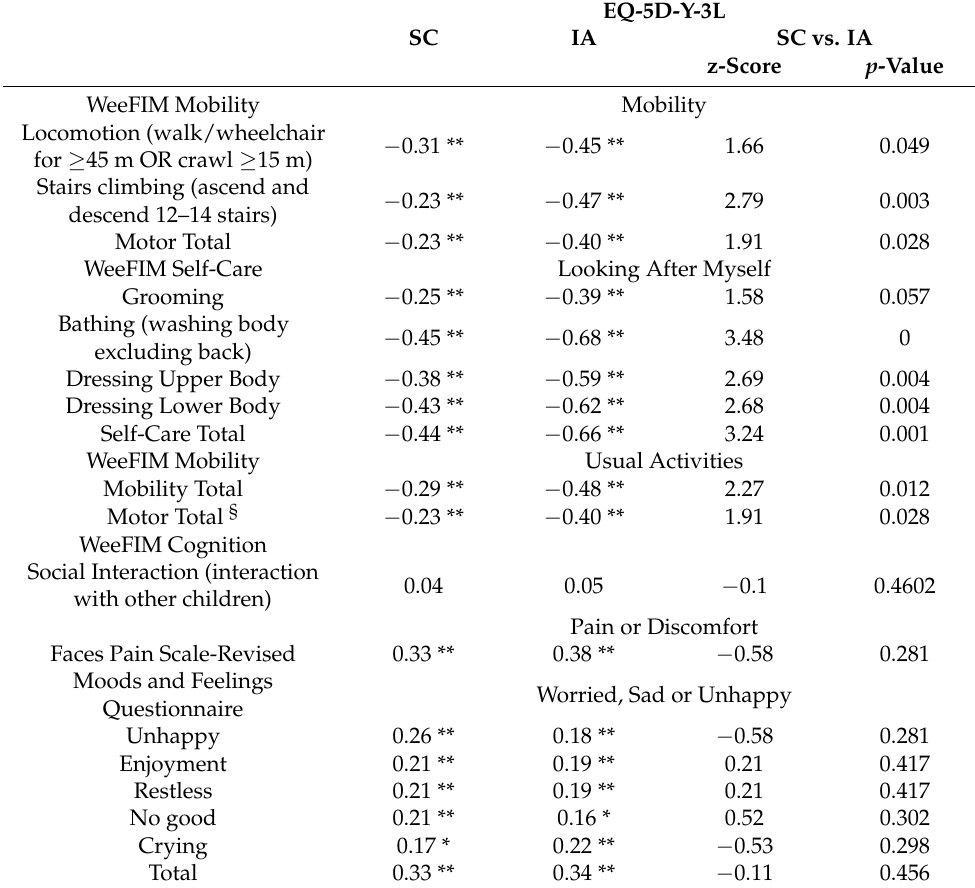
Table 7. Convergent validity of the self-complete and interviewer-administered version and corre- sponding items in the WeeFIM, Faces Scale-Revised and Moods and Feelings